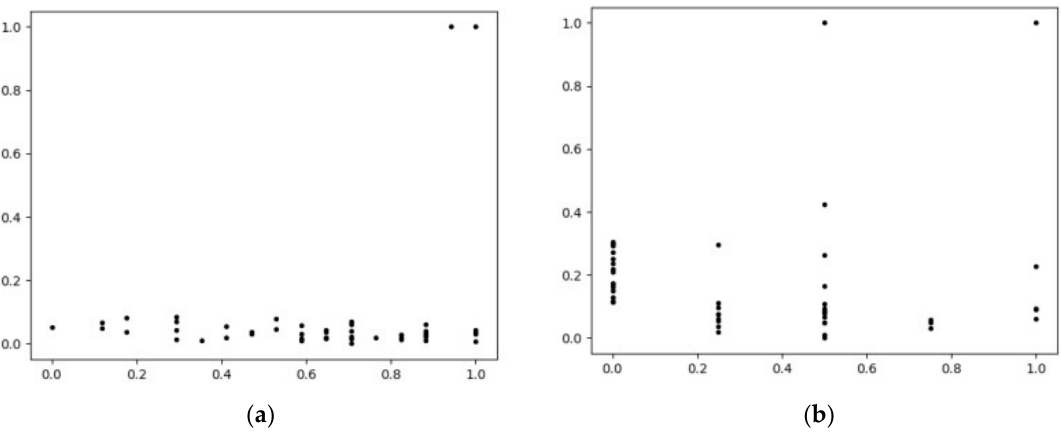
Figure 5. Decision diagram ( n = 50). (a) decision diagram of data1; (b) decision diagram of data2. There is a certain error in the cluster center points seen by the naked eye in the figure.